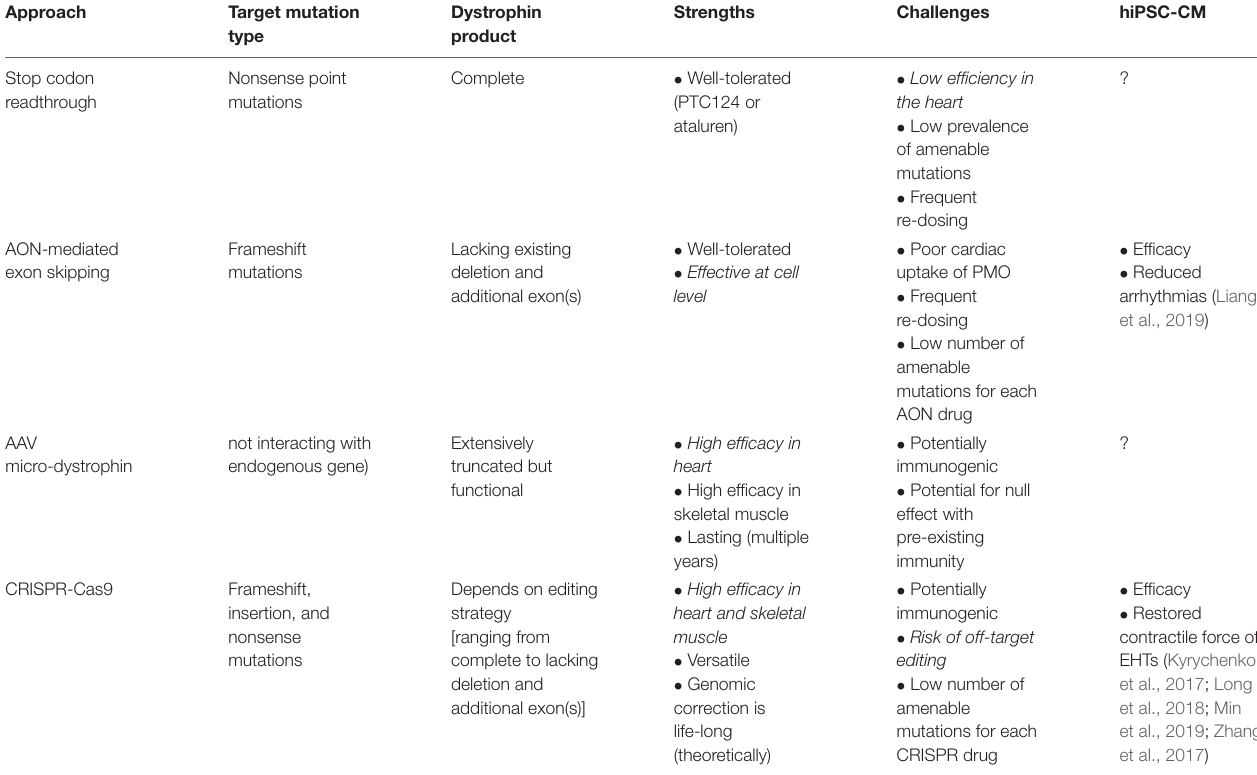
TABLE 3 | Gene therapy strategies and application to hiPSC-CM models to restore dystrophin function.